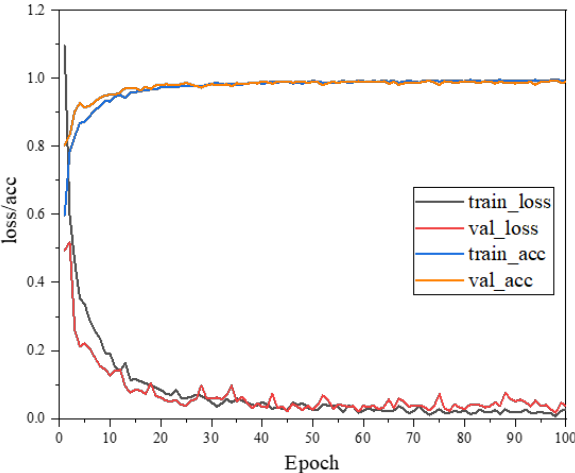
Figure 8. Accuracy and loss curves of RepVGG-CBAM during training.